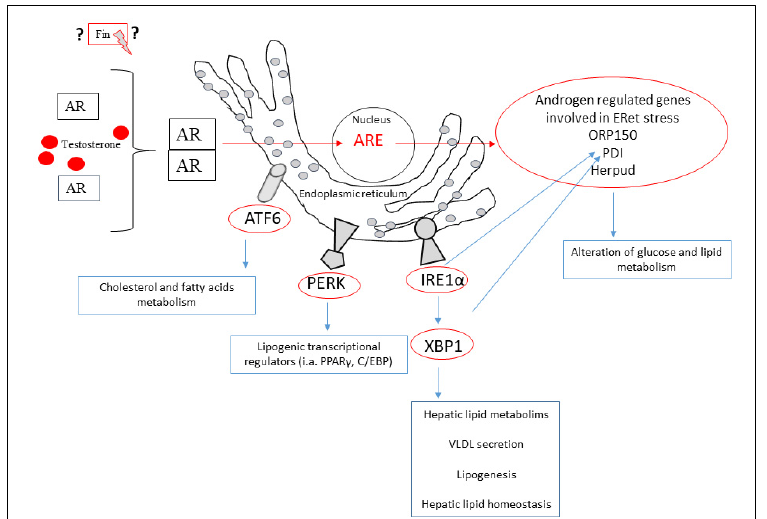
Figure 2. The influence of the Eret stress pathway components on the metabolic processes of lipids in the liver. In the red circles, pathway elements have been marked, the expression of which has been described in the literature, as altered by androgens or their disturbed metabolism. Testosterone binds to androgen receptors (AR), which dimerize and translocate to the nucleus, where they can attach to androgen response elements (AREs) and control the expression of androgen regulated genes (ORP150—oxygen-regulated protein 150, PDI—protein disulfide isomerase, Herpud—homocysteine inducible ER protein with ubiquitin like domain 1). Androgens also affect ATF6, protein kinase R-like endoplasmic reticulum kinase (PERK), inositol-requiring transmembrane kinase/endoribonuclease 1 α (IRE), and X-box binding protein 1 (XBP1). Fiansteride (Fin) may be an additional element modulating ERet stress by influencing the level of androgens. Note: XBP1 is characterized by variable expression depending on the severity of symptoms in some